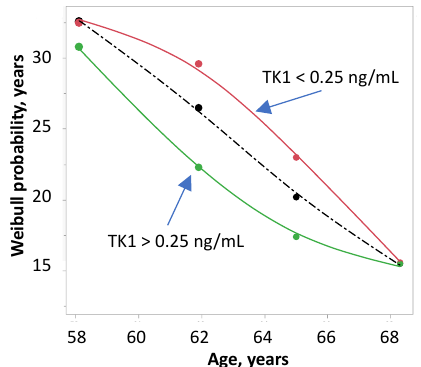
Figure 5. Survival probability of 175 men with prostate cancer stratified by age and TK1 below and above the median. The survival probability was calculated from Weibull-transformed Kaplan–Meier estimates. The shattered line shows the survival probability of age alone.